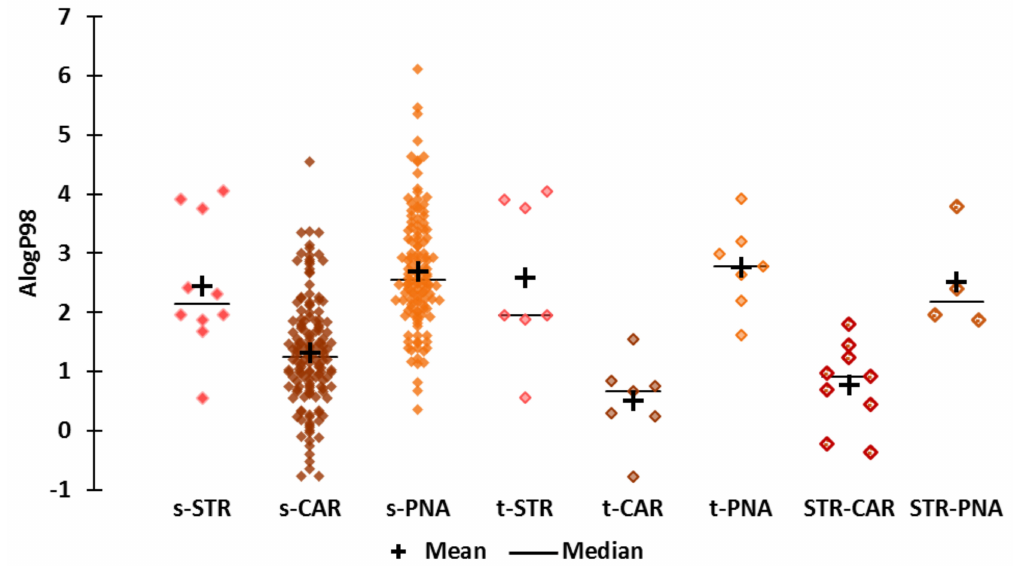
Figure 3. Scattergrams of the AlogP98 values by odor